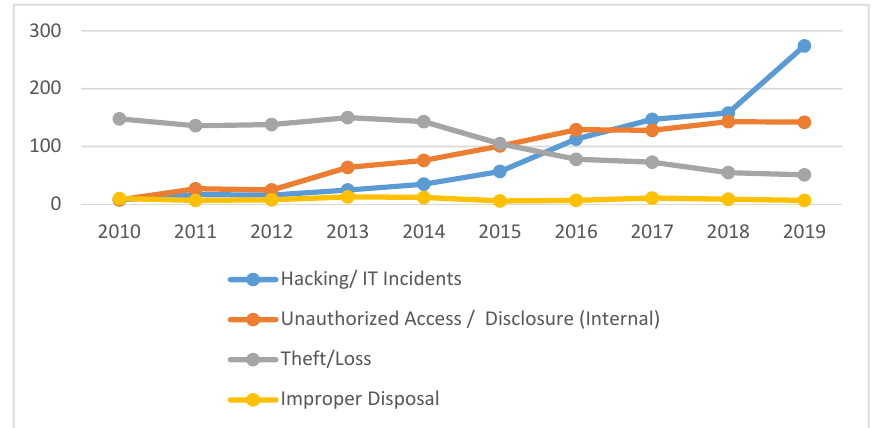
Figure 4. Graphical Presentation of Different Data Disclosure Types.